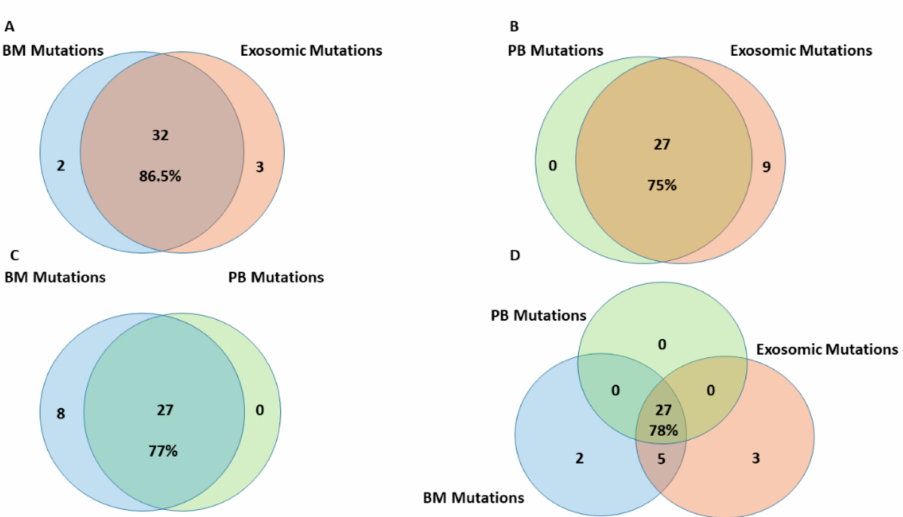
Figure 2. Homology of unique mutations identified in the different DNA sources. ( A ) Homology between BM cellular DNA and exosomal dsDNA; ( B ) Homology between PB cellular DNA and exo- somal dsDNA; ( C ) Homology between BM and PB cellular DNA; ( D ) Homology between exosomal dsDNA, BM and PB cellular DNA. BM, PB and exosomal mutations (identified on the total dsDNA co-isolated with exosomes) are reported in blue, green and red diagrams,